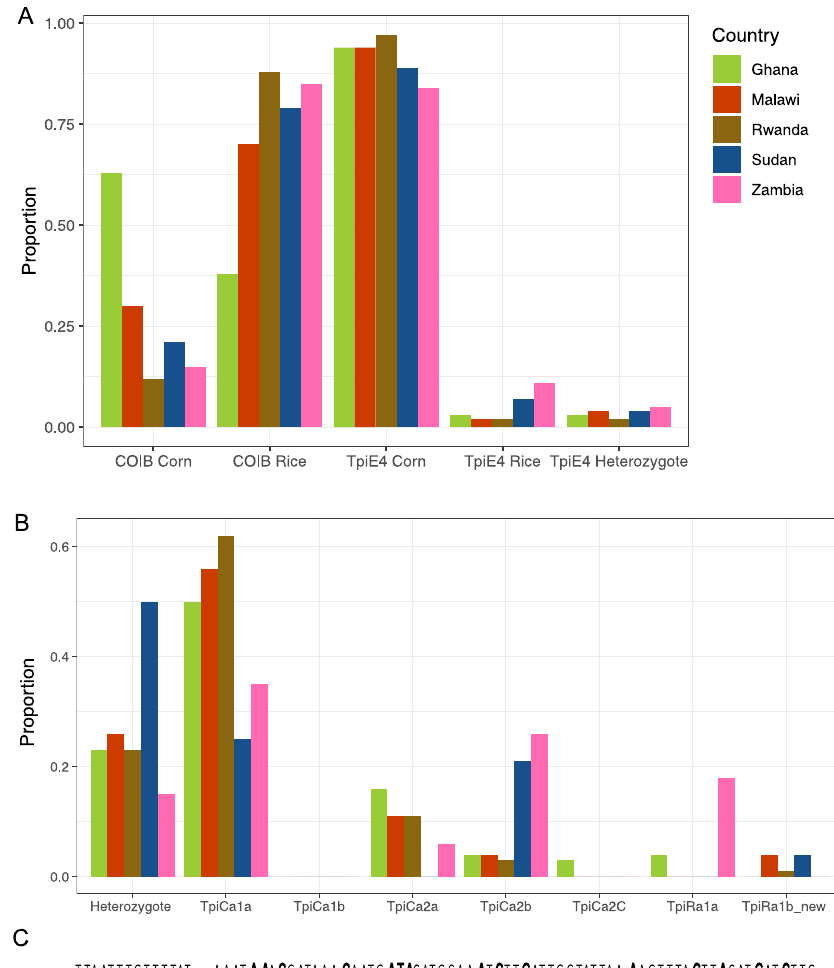
Figure 1. Strain and haplotype identification of FAW larvae using COIB, TpiE4 and TpiI4 markers. ( A ) Strain identification of FAW larvae using COIB and TpiE4 markers. The number of samples for COIB:TpiE4 markers tested per country are Ghana 72:72, Malawi 40:95, Rwanda 127:126, Sudan 28:28 and Zambia 53:44. ( B ) Proportion of each TpiI4 haplotype identified. ( C ) Sequences of each TpiI4 haplotype identified, variable positions are shown in bold. The number of samples for the TpiI4 marker for each country are Ghana N = 70, Malawi N = 27, Rwanda N = 141, Sudan N = 24 and Zambia N =